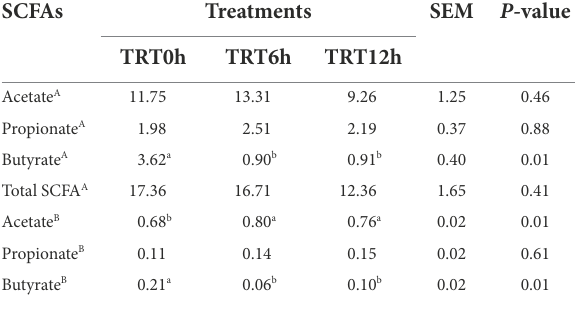
A Indicates differences in SCFA concentration. B Indicates differences in the molar proportion of SCFA. Significance between treatment groups was declared at p < 0.05 and tendencies were declared at p < 0.10. a,b Different superscripts within a row represent